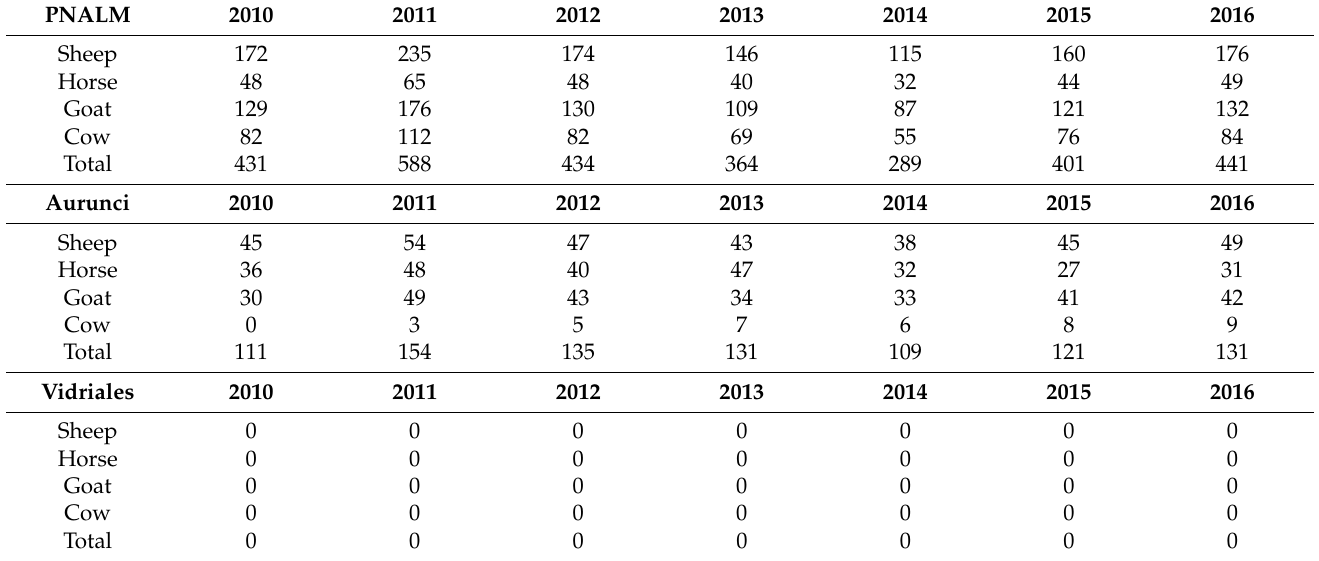
Table 3. Number of livestock heads attacked by wolves in the three study areas (National Park Abruzzo, Lazio, and Molise = PNALM; Regional Park of Aurunci Mountain = Aurunci; Coto de Caza Valle de Vidriales =